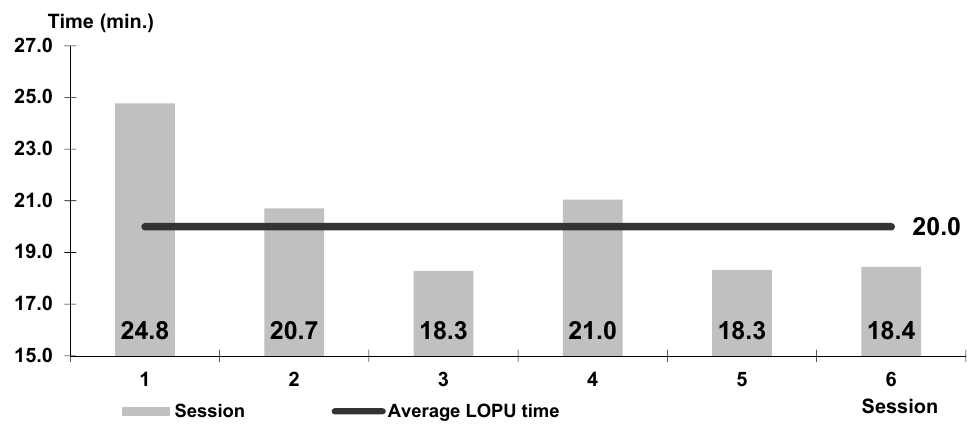
Figure 7. Comparing various L-OPU sessions with respect to percentages of recovered oocytes and oocytes selected for IVM in sheep.